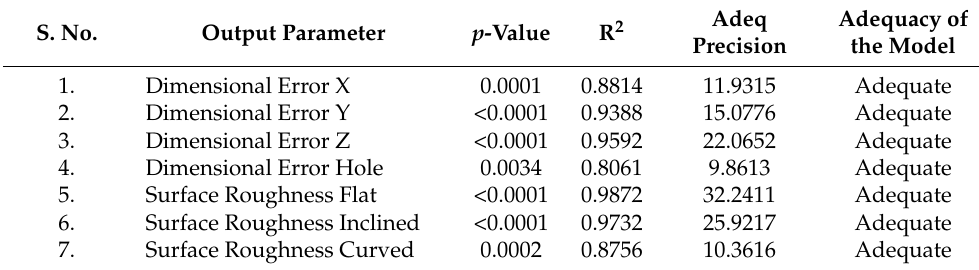
Table 3. Analysis of variance for the quadratic models